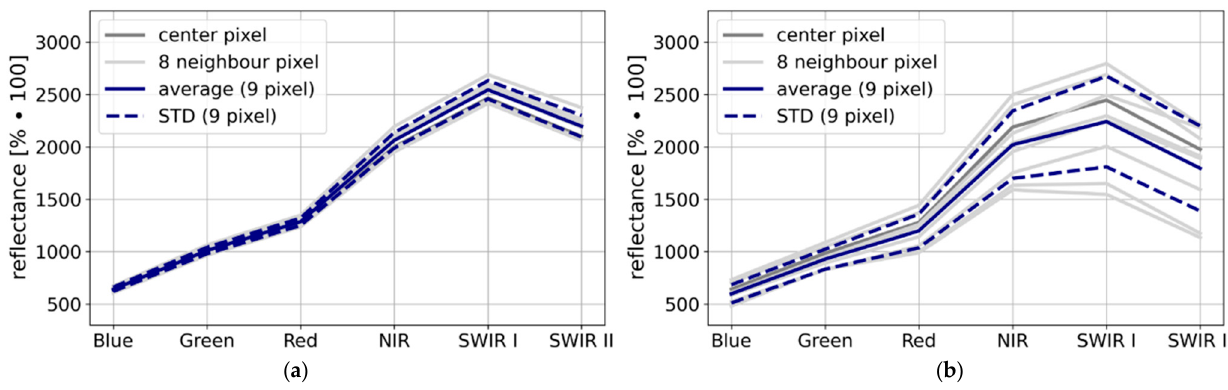
Figure 4. SRC reflectances of the center pixel (dark grey), the eight neighboring pixels (grey), the average reflectance (blue solid), the STDs per pixel cluster (blue dashed) for ( a ) a homogenous pixel cluster and ( b ) a heterogenous pixel cluster.